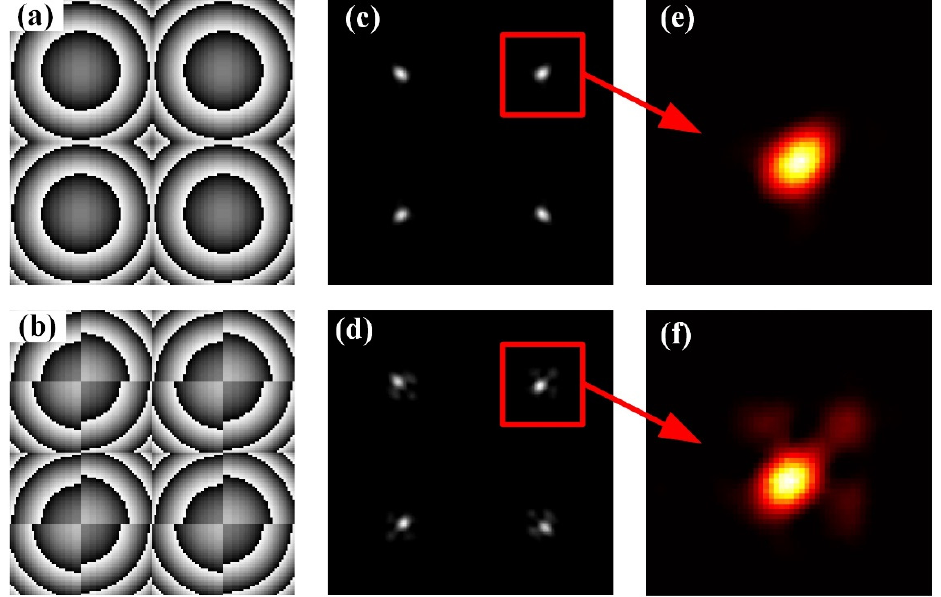
Figure 12. Images loaded on the SLM and camera-acquired spot array images. ( a ) Images of the microlens array. ( b ) Images of the four-quadrant binary phase-modulated microlens array. ( c ) The camera-acquired spot array images of the SHWFS. ( d ) The camera-acquired spot array images of the FBPM-SHWFS. ( e , f ) The single sub-spots with hot colormap of the SHWFS and the FBPM-SHWFS, respectively.